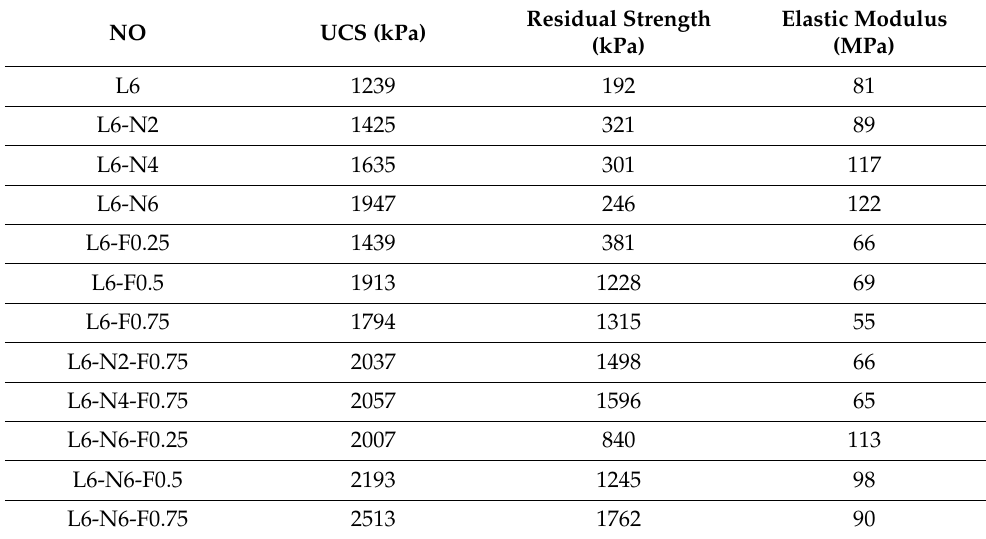
Table 3. Test results of UCS